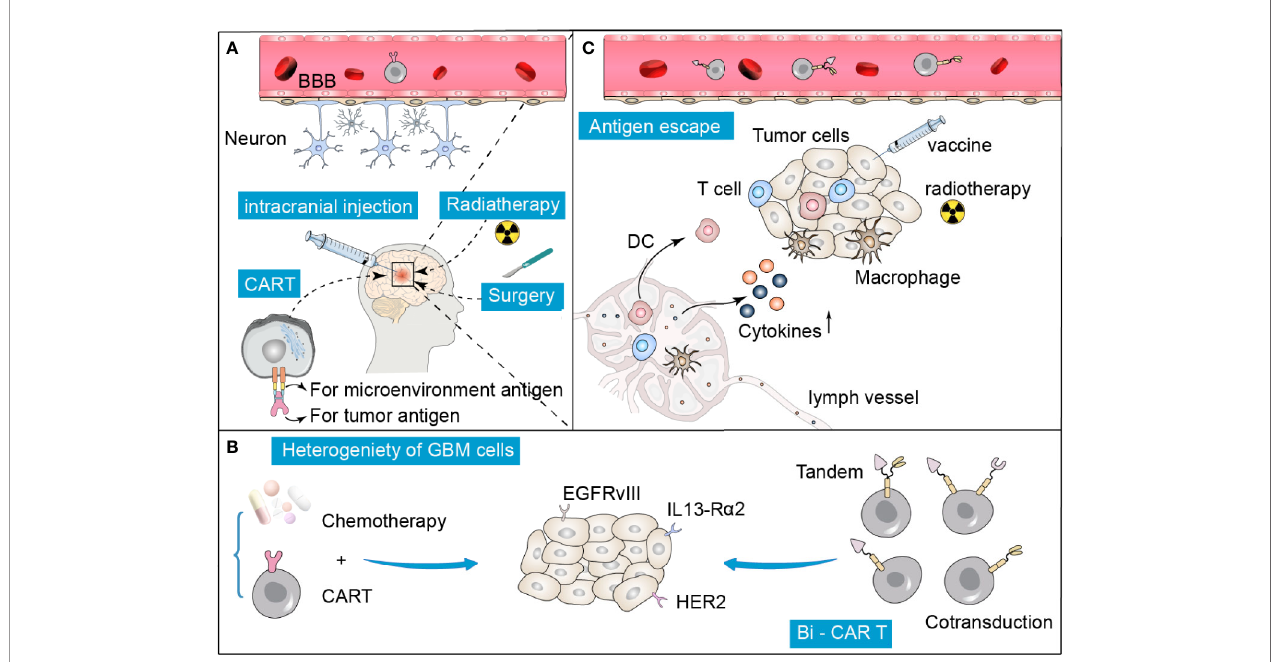
FIGURE 2 | Summary of dif fi culties and possible improvement strategies in CAR T treatment for GBM. (A) The speci fi c anatomy of the blood-brain barrier (BBB) prevents the entry of many drugs, including CAR T cells, which can be overcome to some extent by intracranial direct injection, radiation, or surgery. (B, C) Tumor heterogeneity and antigen escape are the two major reasons that limit the ef fi cacy of CAR T therapy. These obstacles can be overcome by administering a combination of traditional treatments, such as chemotherapy, radiation, and adjuvant vaccines. In addition, the construction of multi-target speci fi c CAR T cells is also a promising